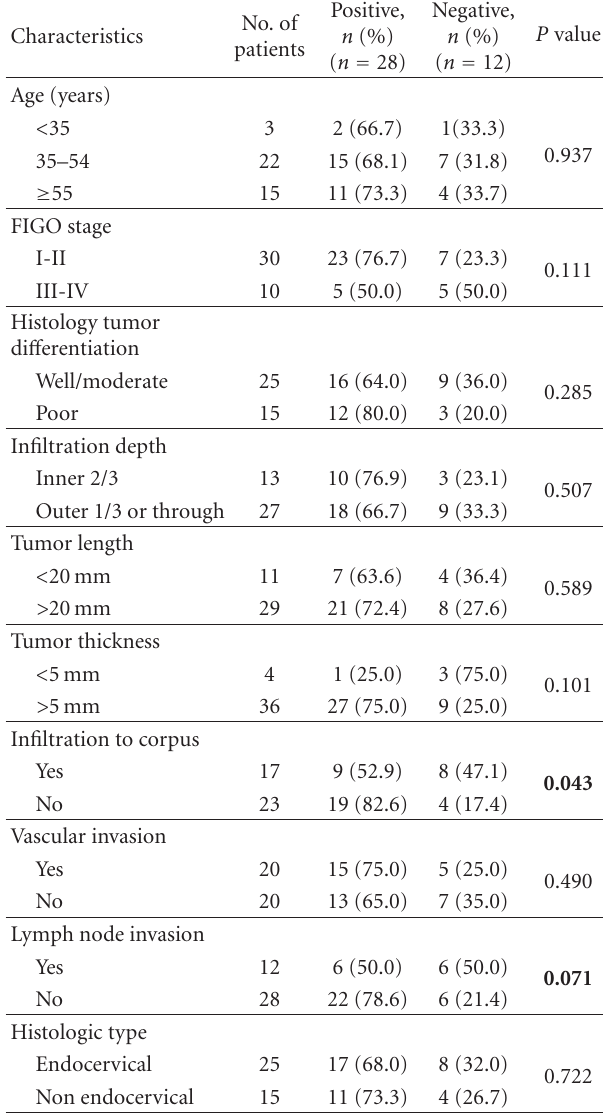
Table 5: Associations between P21waf1 expression and clinico- pathologic parameter for adenocarcinoma of the